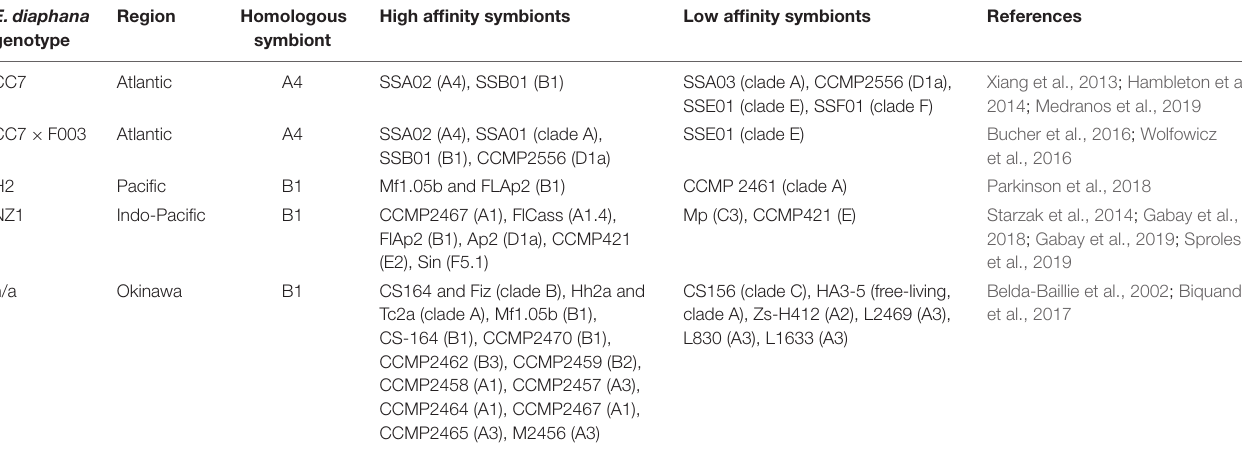
TABLE 1 | Literature describing affinity of E. diaphana genetic lines from different localities for homologous and heterologous